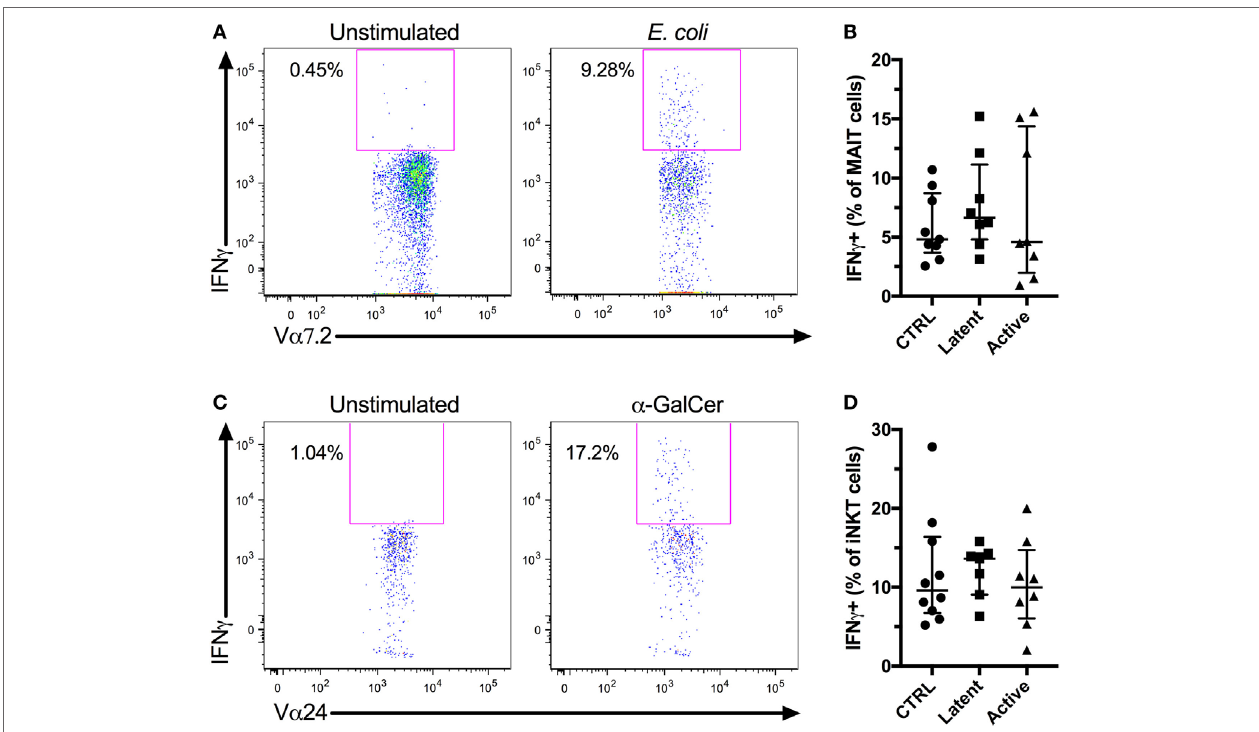
FigUre 3 | In vitro IFN γ production of mucosal-associated invariant T (MAIT) and invariant natural killer T (iNKT) cells. Peripheral blood mononuclear cells (PBMCs) from HIV-1-uninfected subjects were stimulated with Escherichia coli or α -GalCer, and IFN γ production was evaluated for MAIT and iNKT cell, respectively. Representative flow plots showing MAIT cells IFN γ production by unstimulated and E. coli -stimulated PBMCs (a) . IFN γ production by MAIT cells after E. coli stimulation for controls ( n = 9), latent Mycobacterium tuberculosis (Mtb) ( n = 8), and subjects with active Mtb infection ( n = 8) (b) . Representative flow plots showing iNKT cells IFN γ production by unstimulated and α -GalCer-stimulated PBMCs (c) . IFN γ production by iNKT cells after α -GalCer stimulation for controls ( n = 10), latent Mtb ( n = 7), and subjects with active Mtb infection ( n = 8) (D)